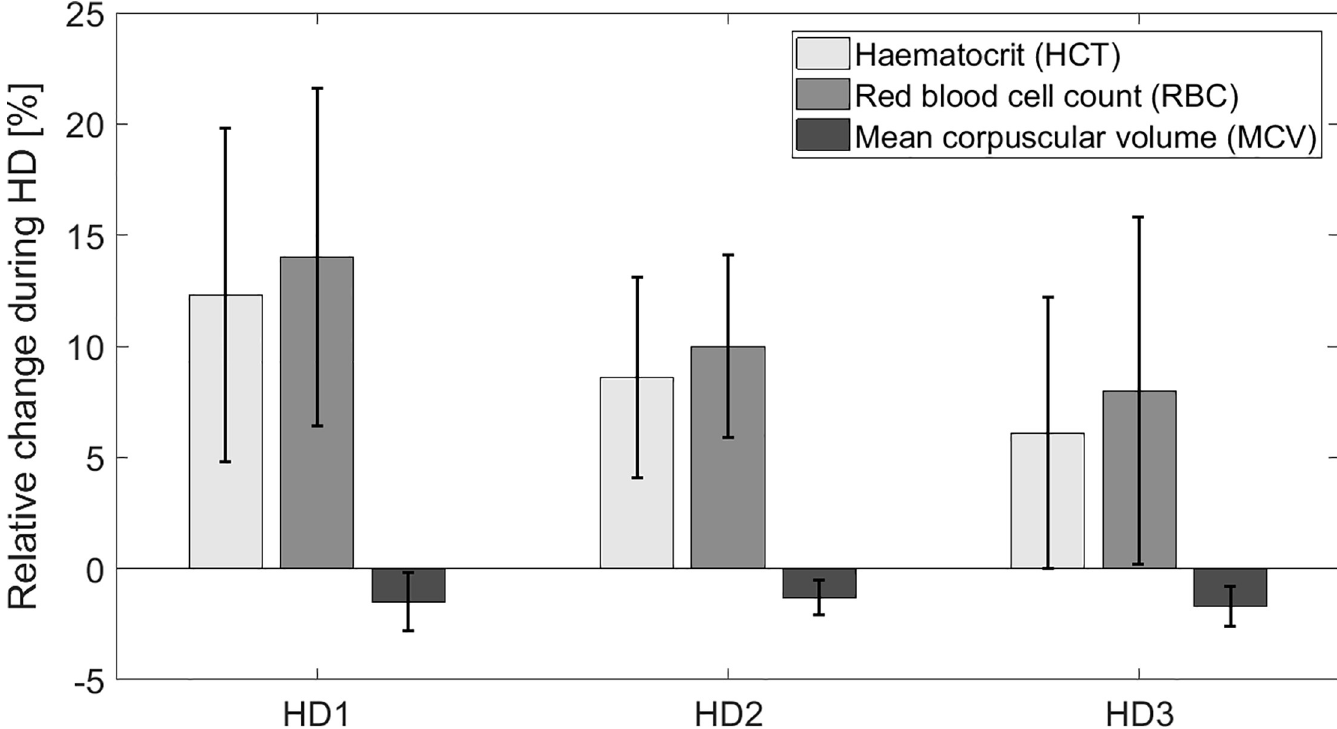
Fig 2. Dialysis-induced changes in red blood cell parameters. Relative change (mean ± SD) of hematocrit (HCT), red blood cell count (RBC) and mean corpuscular volume of red blood cells (MCV) during three consecutive hemodialysis sessions in the week in the analyzed group of patients based on the laboratory measurements of arterial blood samples taken at the beginning and at the end of each session (see Table